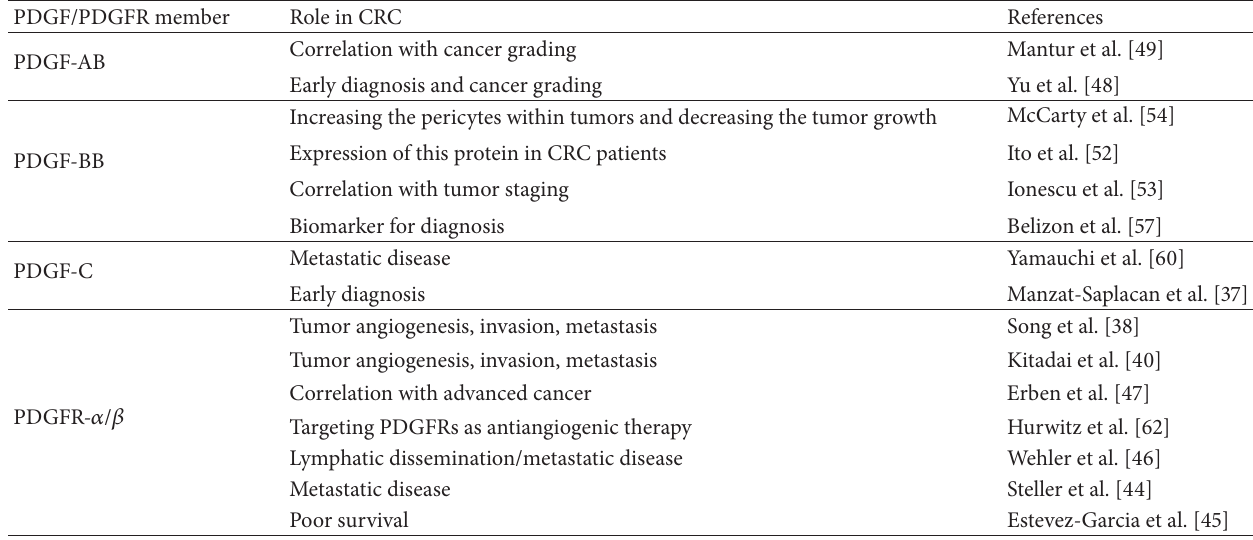
Table 1: The role of PDGF/PDGFR families in colorectal